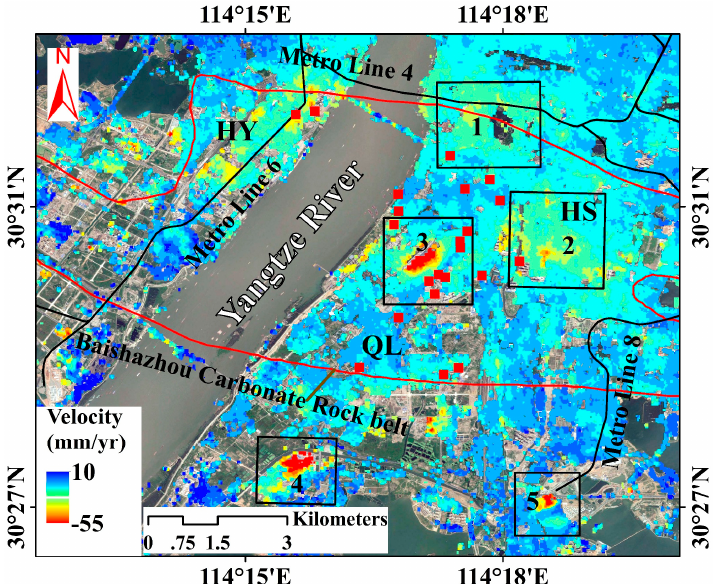
Figure 12. Surface vertical deformation rates map derived by SBAS InSAR superimposed on Google Earth image covering Region S4. Black lines denote the Wuhan Metro Lines, including metro lines in operation and under construction. The area enclosed by red line represents the Baishazhou Carbonate Rock belt. The red square denotes karst surface collapse. Areas 1, 2, 3, 4, and 5 marked with black rectangles are significant subsidence areas in Region S4.